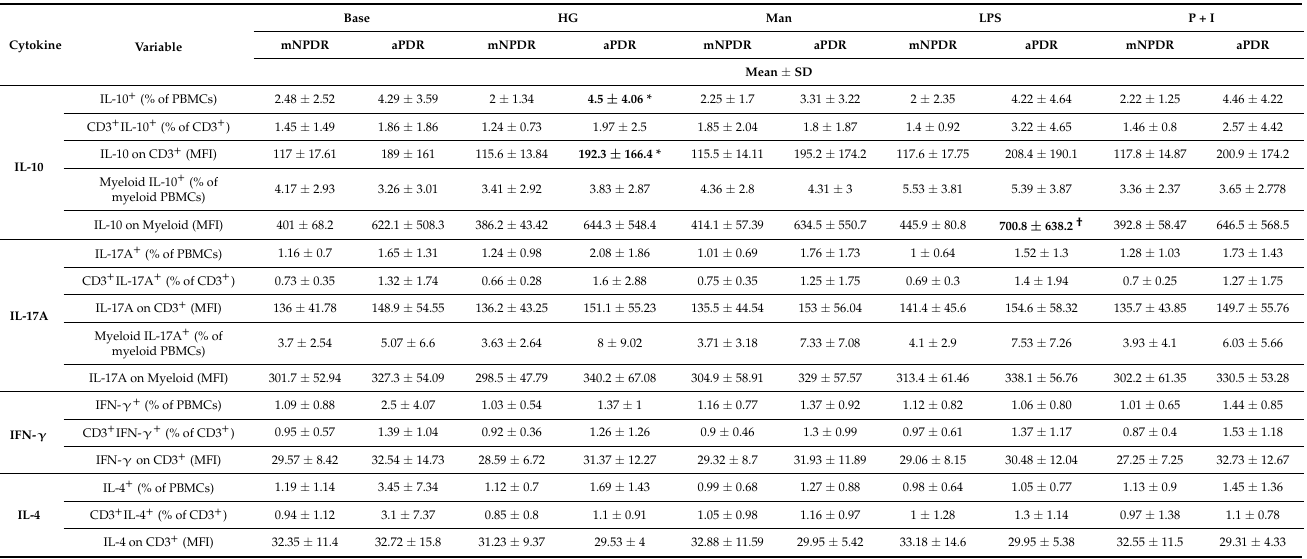
Table A5. IFN- γ , IL-4, IL-8, IL-10 and IL-17A expression in PBMCs from aPDR vs. mNPDR patients in different culture